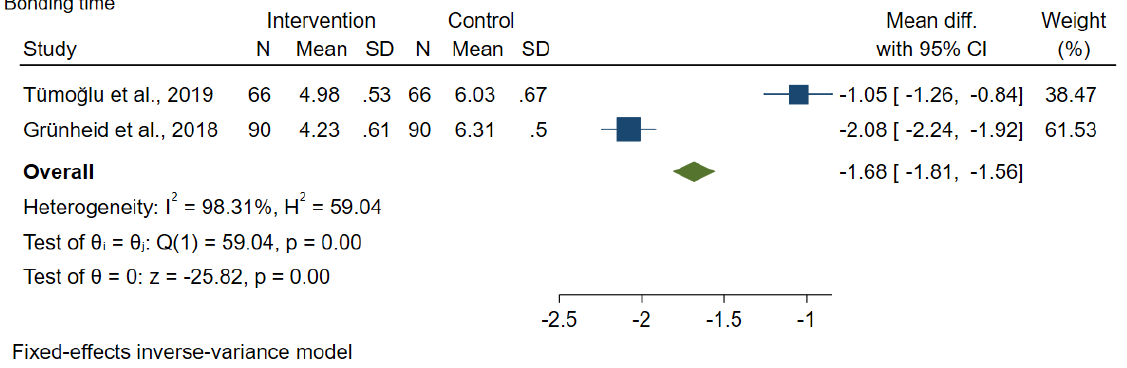
Fig. 3. Forest plot showed Mean differences in bonding time between flash-free and control groups.